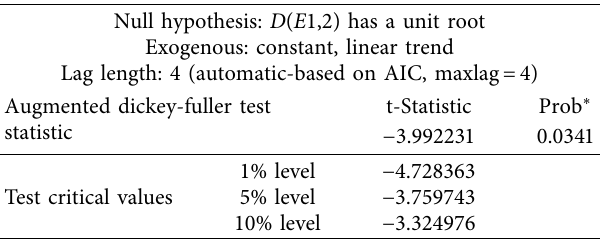
Table 4: Stationarity test results of fiscal expenditure adjustment data in China from 1998 to 2019.